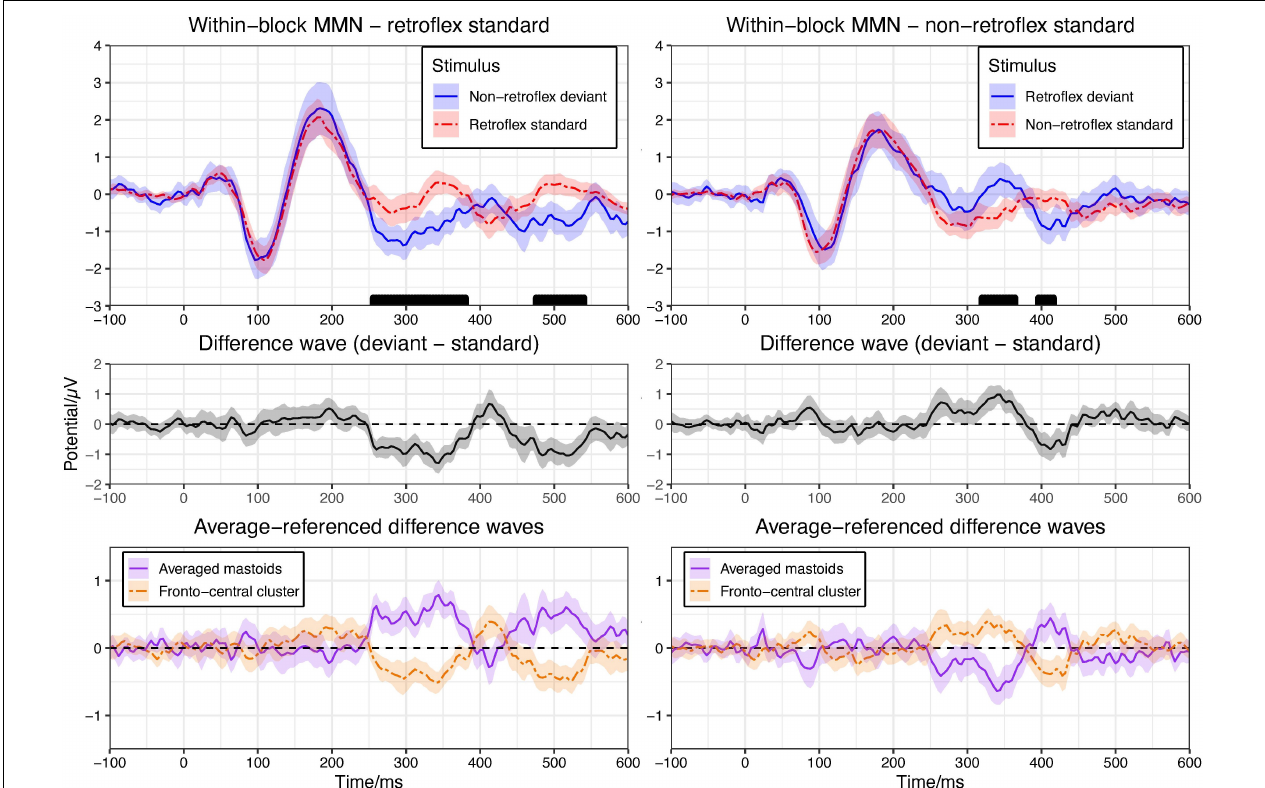
FIGURE 2 | Upper panel: means of grand average ERPs at electrodes Cz, Fz, FC1/2. Ribbons represent 95% confidence intervals. Rug plots along the x-axes mark time points with significant differences for greater than 30 ms in duration (pFDR < 0.05). Plots are arranged to show the within-block MMNs. Left panel compares the ERPs to the retroflex standard and the non-retroflex deviant; right panel compares the ERPs to the non-retroflex standard and the retroflex deviant. Middle panel: difference waves of grand average ERPs at the fronto-central cluster (Cz, Fz, FC1/2). Lower panel: difference waves of grand average ERPs of averaged mastoids and the fronto-central cluster (Cz, Fz, FC1/2) with an average